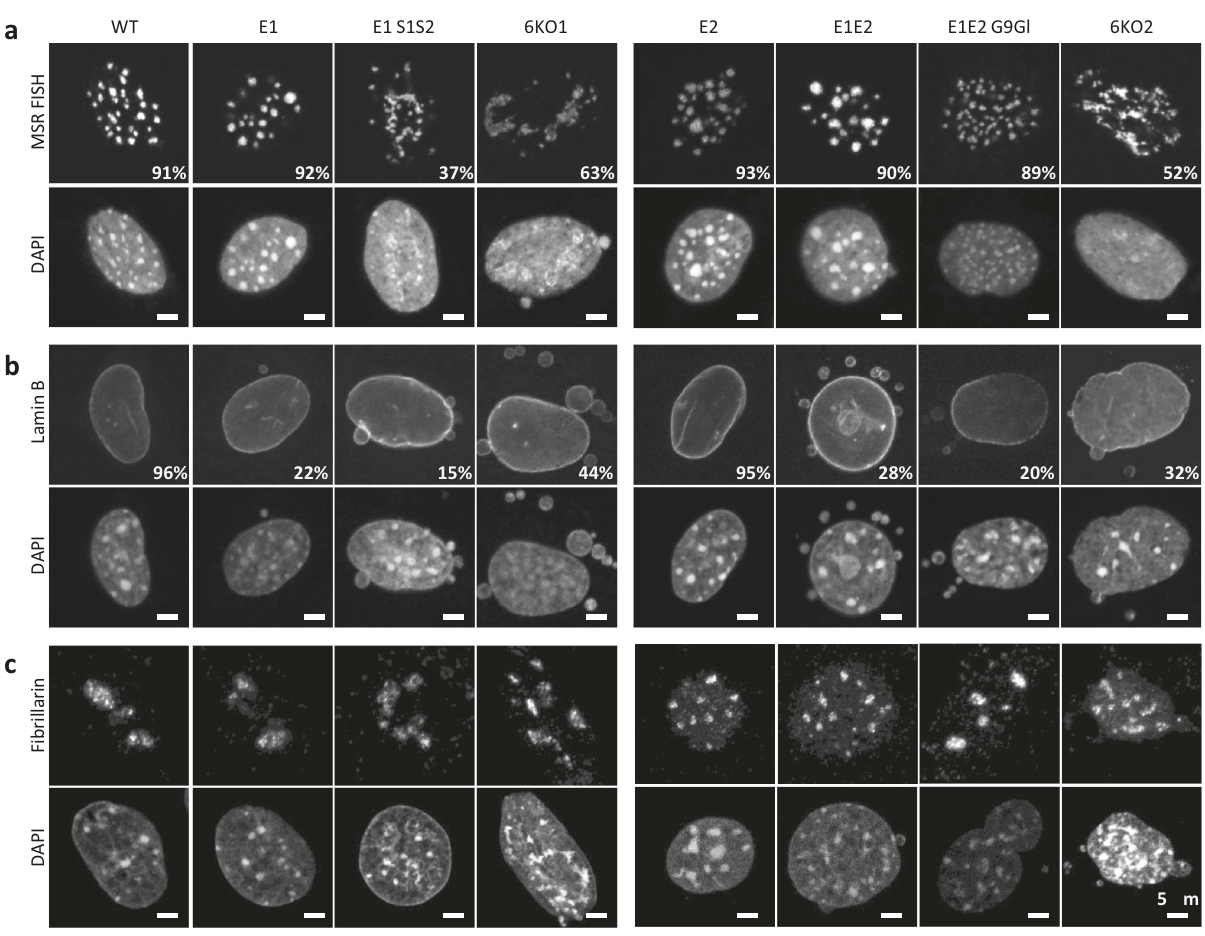
Fig. 6 Collapse of heterochromatin in compound H3K9 KMT-mutant MEF cells. a DNA FISH for major satellite repeats (MSR) in control and compound H3K9 KMT mutant. Percentages indicate cells that display the shown pattern. N = 501 cells examined for WT, 303 for E1 , 352 for E1 S1S2 , 304 for 6KO1 , 308 for E2 , 311 for E1E2 , 301 for E1E2 G9Gl , and 309 for 6KO2 over three independent experiments. For each image, lower panels show DAPI counterstaining of the same nuclei. b Immuno fl uorescence for Lamin B, marking the nuclear lamina. Percentages indicate cells that display the shown pattern. N = 680 cells examined for WT, 785 for E1 , 302 for E1 S1S2 , 305 for 6KO1 , 573 for E2 , 499 for E1E2 , 558 for E1E2 G9Gl, and 427 for 6KO2 over three independent experiments. For each image, lower panels show DAPI counterstaining of the same nuclei. c Immuno fl uorescence for Fibrillarin, marking nucleoli. Representative images ( N = 100 cells) are shown. For each image, lower panels show DAPI counterstaining of the same nuclei. Scale bars represent 5 μ